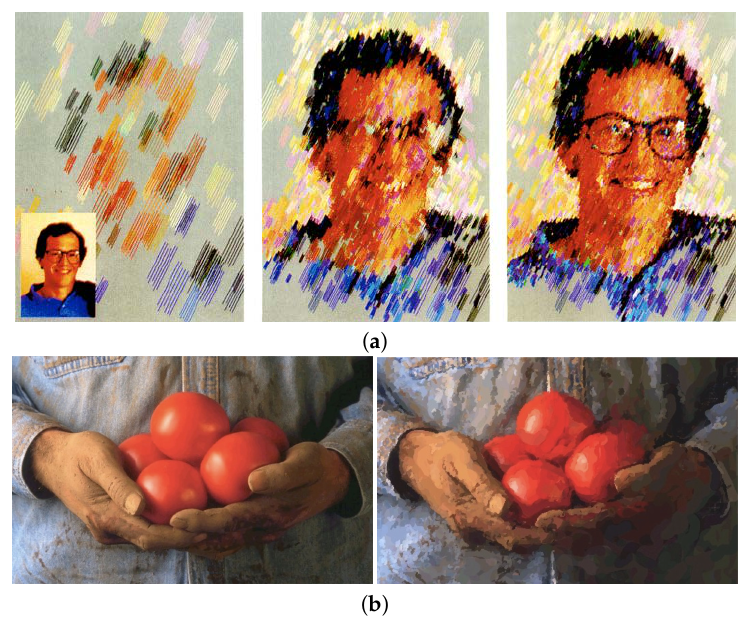
Figure 6. Painterly rendering algorithms that process an input photograph, using hand-coded rules and algorithms. ( a ) Paul Haeberli’s interactive painting system (Haeberli 1990). Images used by permission of the ACM. ( b ) My automatic painting system (Hertzmann 1998) processes a photograph without user input aside from selecting some parameter settings.